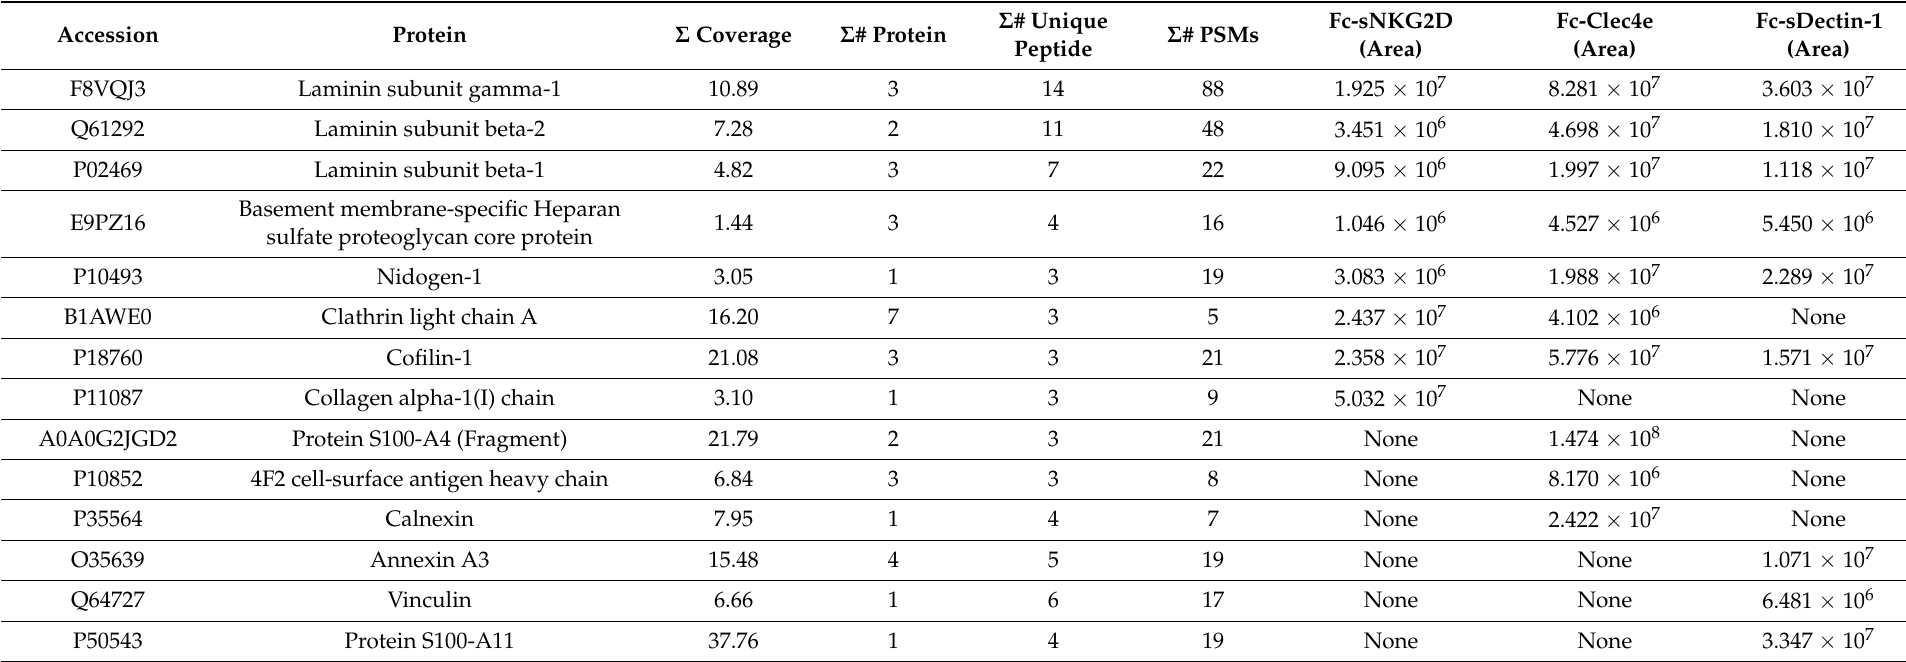
Table 1. Mass Spectrometry Data for tumor cell proteins interacting with Fc-sNKG2D, Fc-sClec4e and